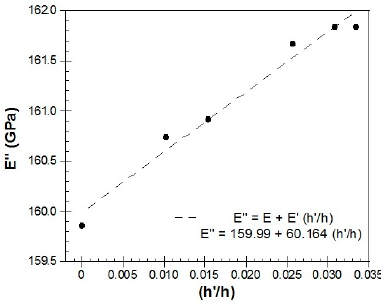
Figure 7. Total Young’s modulus ( E ”) measured as a function of the ratio h ’/ h (width of the deposited ZnO layer/width of Metglas 2826MB strip).